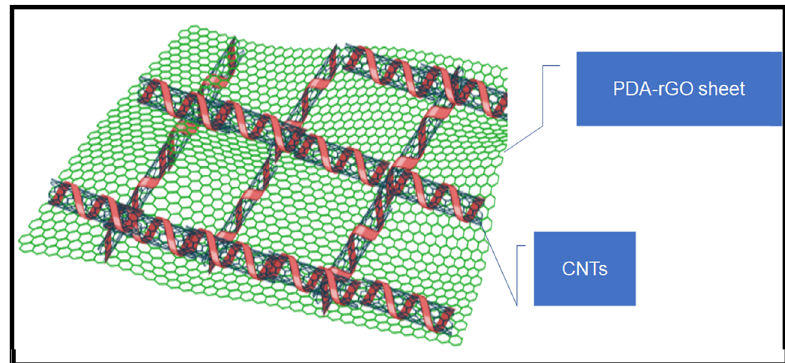
Figure 20: Schematic illustration of TCFs with ultra - adhesion, relatively low roughness, and excellent electrical